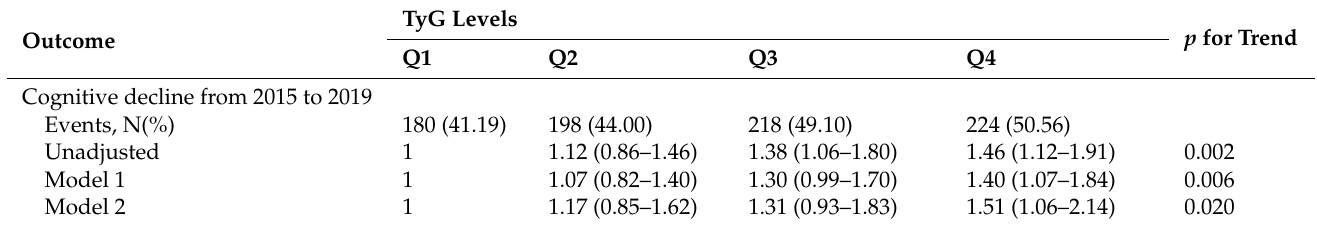
Table 3. ORs and 95% CIs for the association between the TyG index and the clinical outcome.